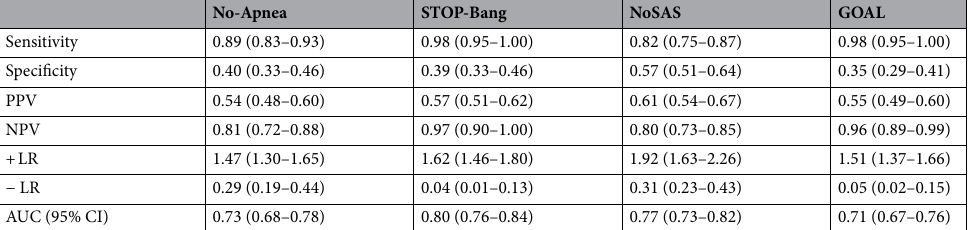
Table 4. Predictive parameters of the four screening tools at AHI ≥ 30 events/h. AHI apnea hypopnea index, PPV positive predictive value, NPV negative predictive value, + LR positive likelihood ratio, − LR negative likelihood ratio, AUC area under the curve. Data are presented as values (95% confidence intervals).